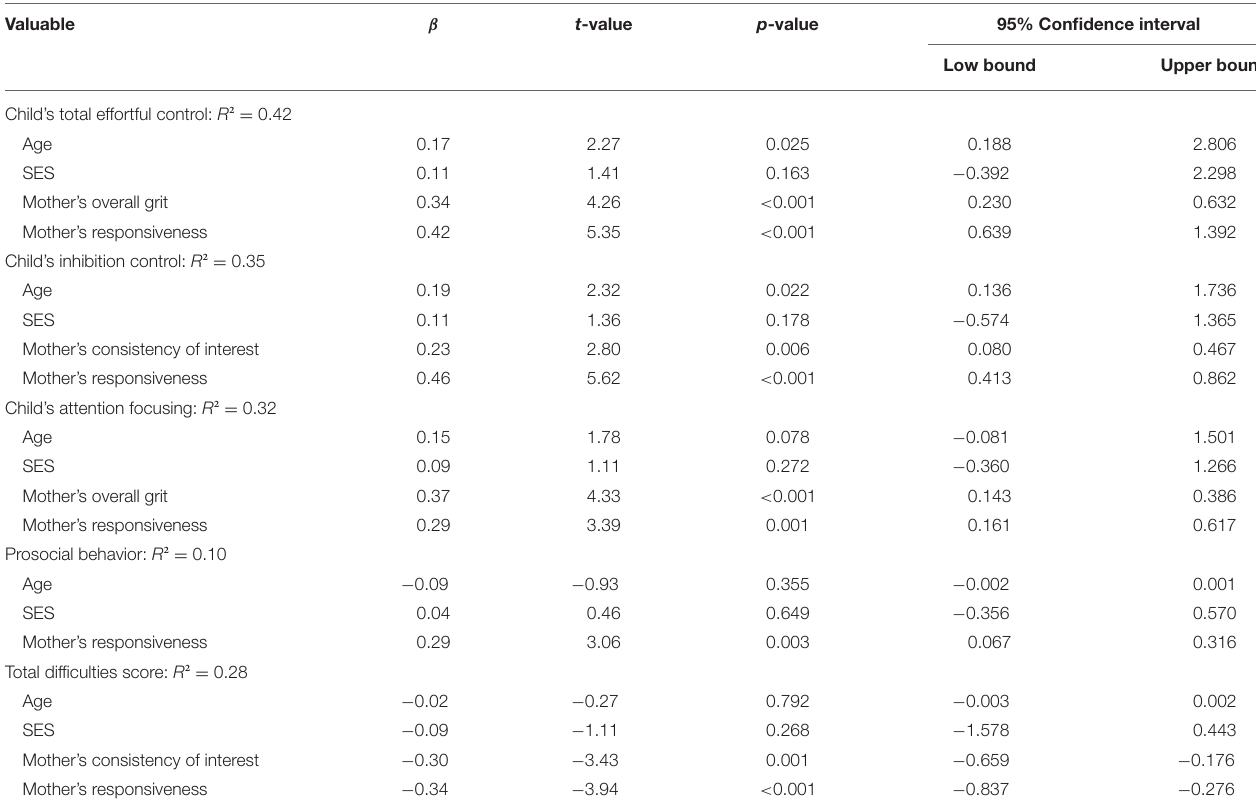
TABLE 3 | Results of hierarchical multiple linear regression analyses predicting child’s self-control, prosocial behavior, and difficulties from mother’s persistence and parenting style. Valuable β t -value p -value 95% Confidence interval